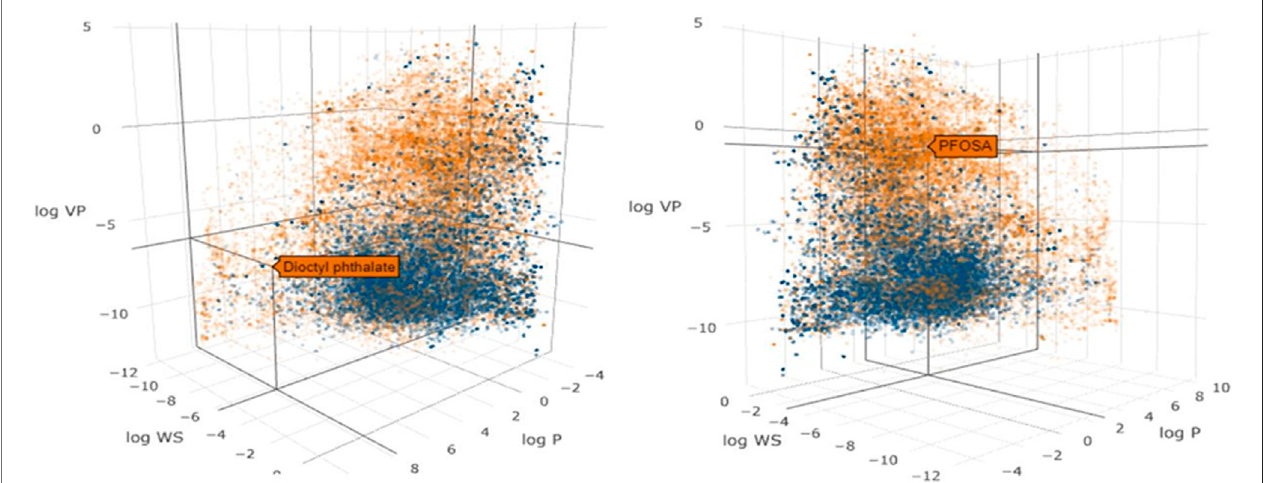
FIGURE 2 | Scatter plot of the physicochemical properties of environmental chemicals (gold dots) and pharmaceuticals (blue dots) in the CERAPP database. The axes represent vapor pressure (log VP), water solubility (log WS) and lipophilicity (log P). Two different views are shown to illustrate the properties of the environmental chemicals, dioctyl phthalate (left) and PFOSA (right).